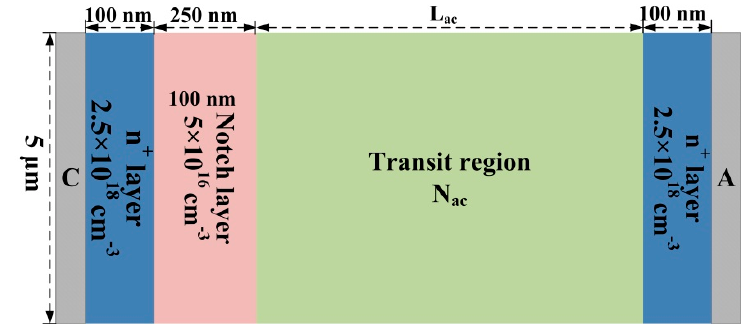
Figure 1. Schematic structure of n + -n − -n-n + structural GaN Gunn didoe.